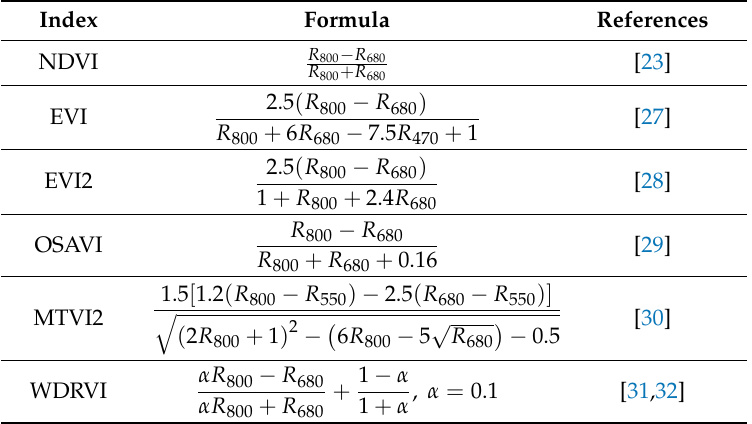
Table 1. Vegetation indices used in this study.